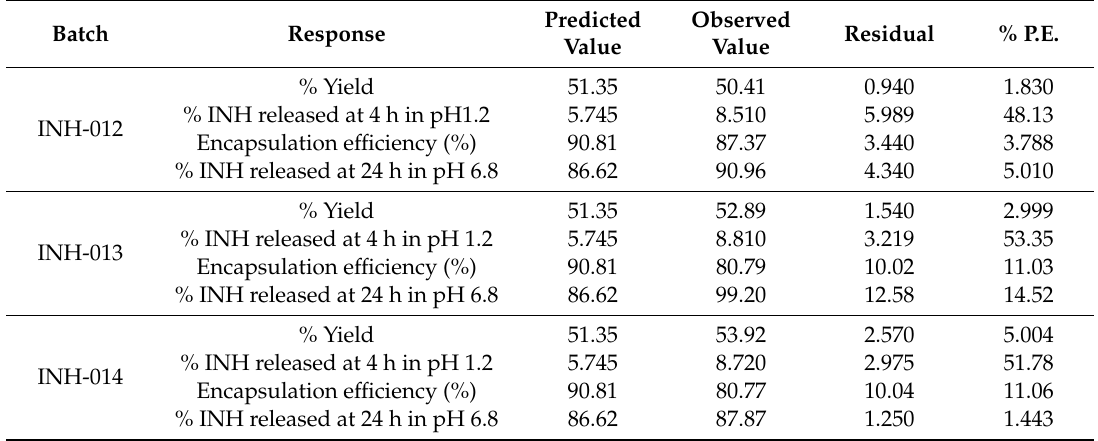
Table 8. Comparison of predicted and experimentally derived